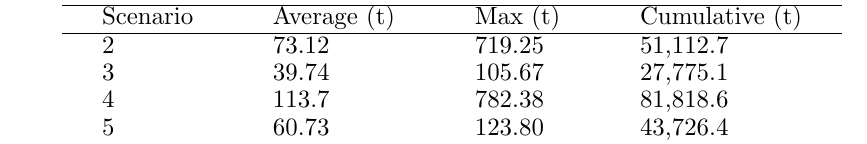
Table 3. Summary of HALEU mass required in each transition scenario. Average values are based on when the advanced reactors are first deployed, and the maximum value is for a single time step.